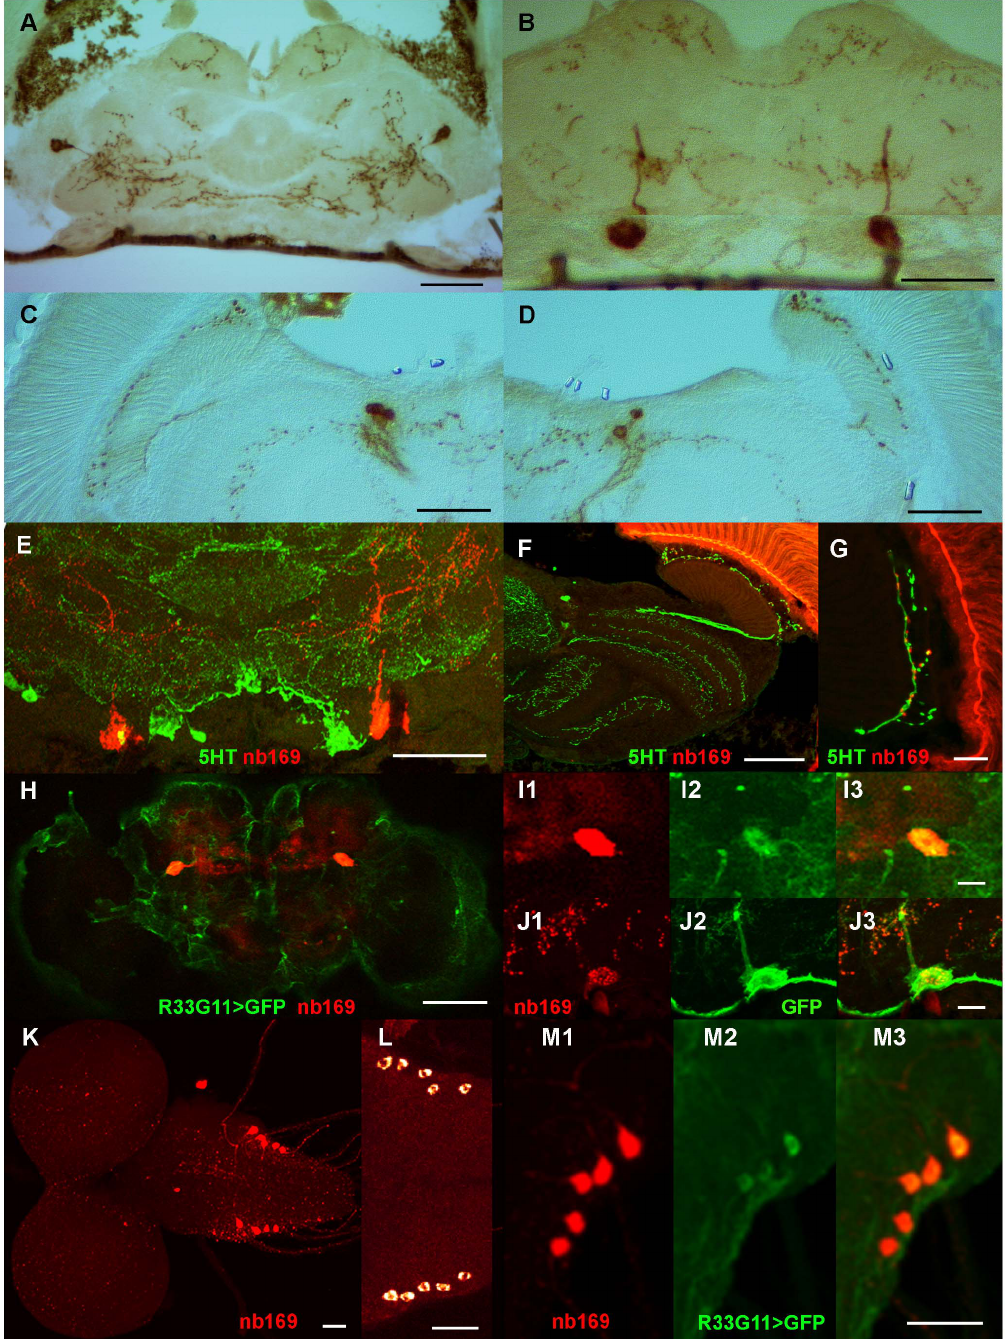
Figure 4. Staining details for mAb nb169. (A-D) The horizontal cryo-sections stained with mAb nb169 and DAB development show the cell bodies in the lateral protocerebrum at the dorso-ventral level of the fan-shaped and ellipsoid bodies (A), the giant neurons in the caudal cellular cortex with their main neurite (in an adjacent section) at the level of the noduli (B), and the cell bodies innervating the accessory medulla, a horizontal layer of the medulla, and a fiber extending to and branching with varicosities in the lamina cortex (C, D). (E-G) Horizontal cryo-sections double-stained with nb169 (red) and anti-serotonin antiserum (green) demonstrate that serotonergic neurons and cells that contain the nb169 antigen are distinct but that their neurites in the lamina cortex are closely apposed. (H-J) GFP (green) expressed under the control of the Janelia Gal4 line R33G11 co- localizes with the nb169 antigen (red) in frontal confocal optical section (H, I1-3) and in horizontal cryo-section (J1-3). (K-M) In the larval nervous system the nb169 antigen (red) is localized in 10 cells (K, L) of which at least 8 also express GFP (green) under the control of R33G11-Gal4 (M, enlargement of K). Scale bars in A-F, H, K-M: 50 m m; in G, I, J: 10 m m.